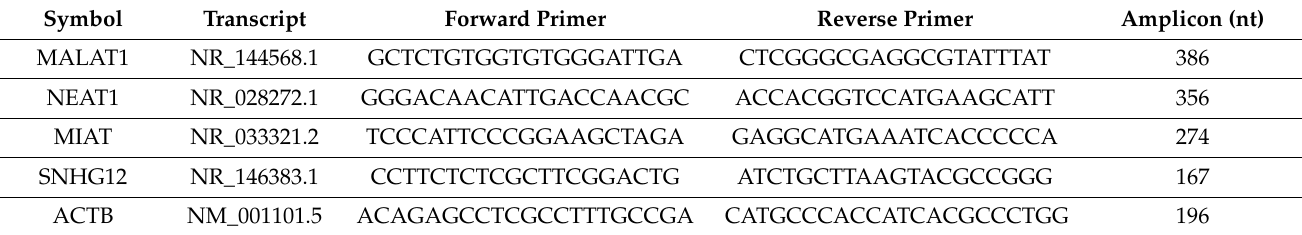
Table 3. Forward and reverse oligonucleotide primers used for gel-based RT-PCR